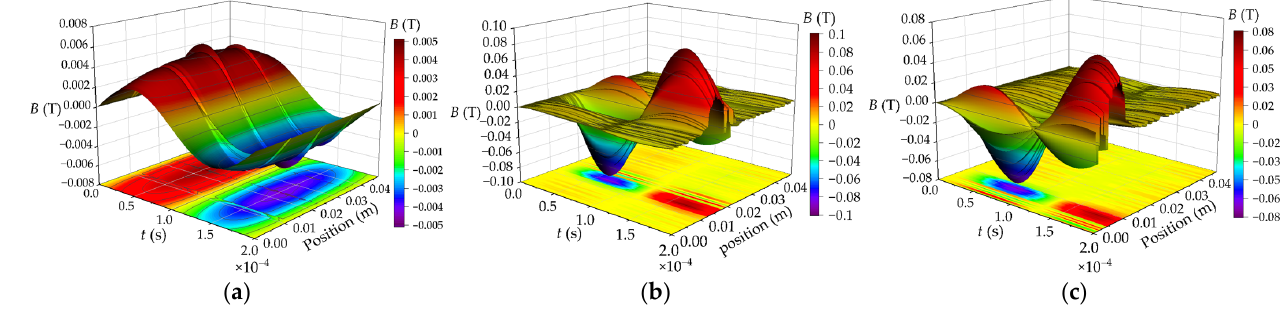
Figure 9. Comparison of axial magnetic flux leakage distribution of continuous winding ( a ) Normal condition; ( b ) Middle-winding short circuit; ( c ) End-winding short circuit.